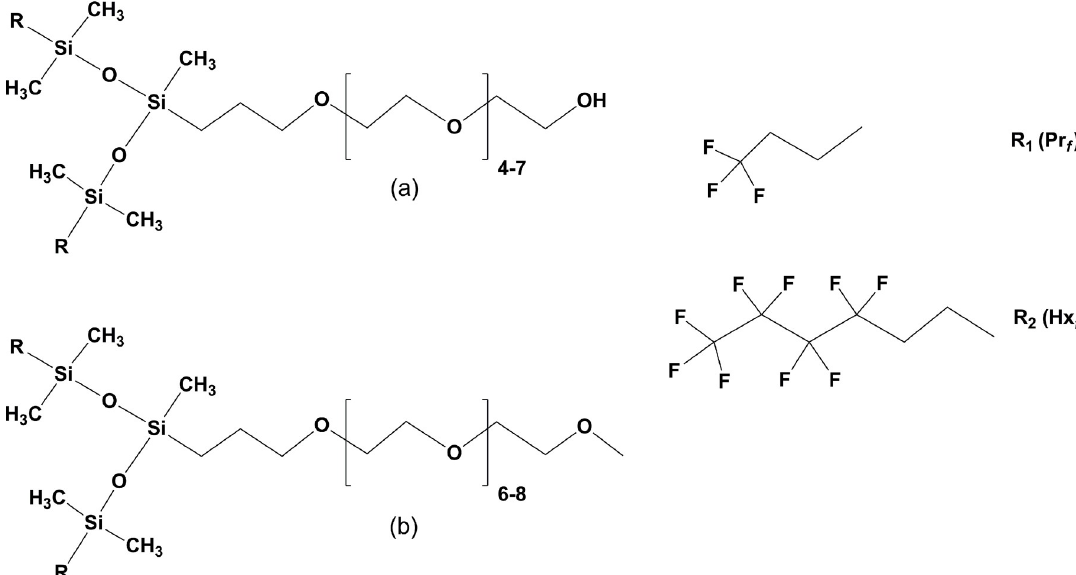
Fig 3. Nonionic fluorosilicone surfactants. The amphiphilic molecules are produced by reacting SiH functionalized branched disiloxanes hydrophobes with allyloxy(polyethylene oxide) following reference [50]. Two different hydrophiles (a, b) and two hydrophobes are shown: one with the 3,3,3-trifluoropropyl (R 1, Pr f ) and 3,3,4,4,5,5,6,6,6-nonafluorohexyl (R 2, Hx f